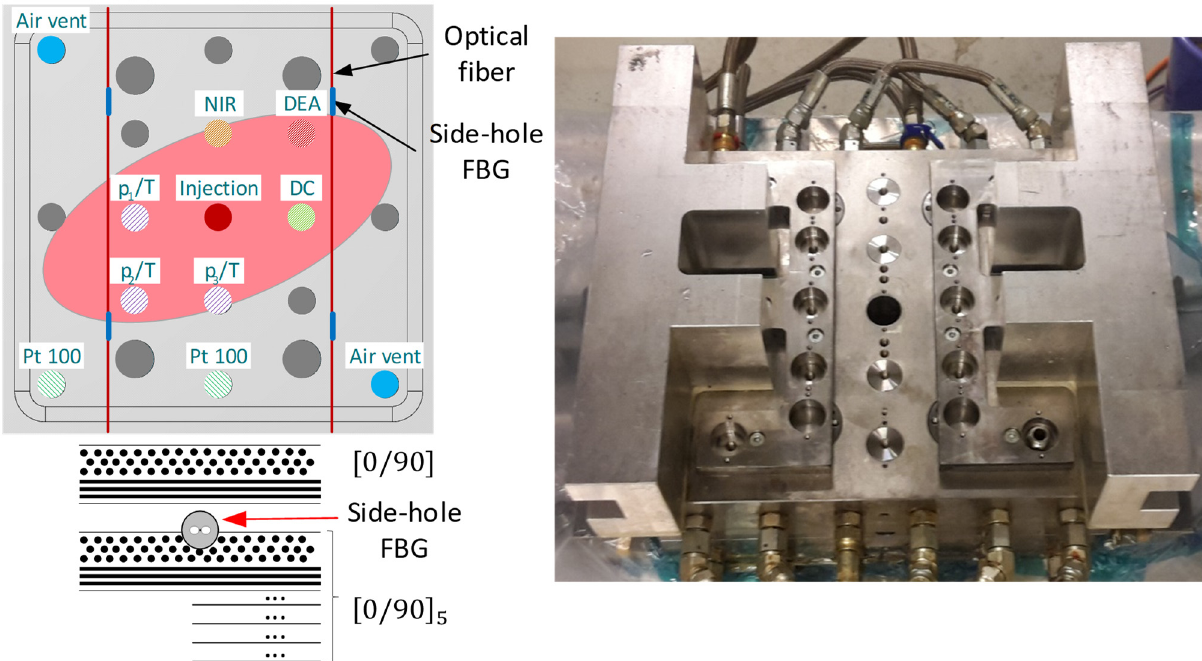
Figure 3. Top view on the upper mold half, showing available sensor positions, sensor fixations and the central injection point ( right ). Schematic view of the upper mold half, showing sensor types and positions used for the measurements as well as the expected flow front orientation ( left ).